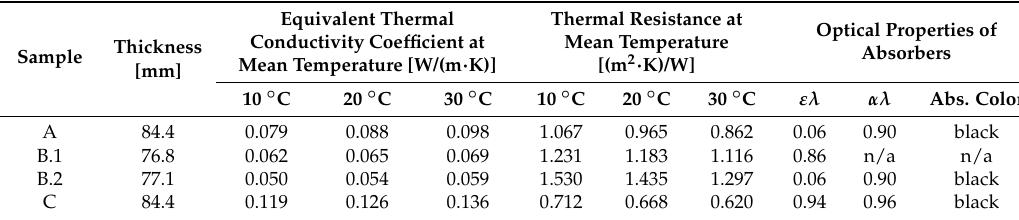
Figure 6. Tested absorber surfaces, transparent insulation application and final tested setup, ( a ) component with selective metal sheet; ( b ) gypsum board surface without finishing; ( c ) component with black painted metal sheet; ( d , e ) transparent insulation applying; ( f ) test setup exposed by solar simulator; ( g ) test setup model and its sensor positioning, thermocouples (TC) installed between layers, on interior and exterior surfaces. Thermocouples are located in the middle of each component. Table 6. Thermal resistance at mean temperature.